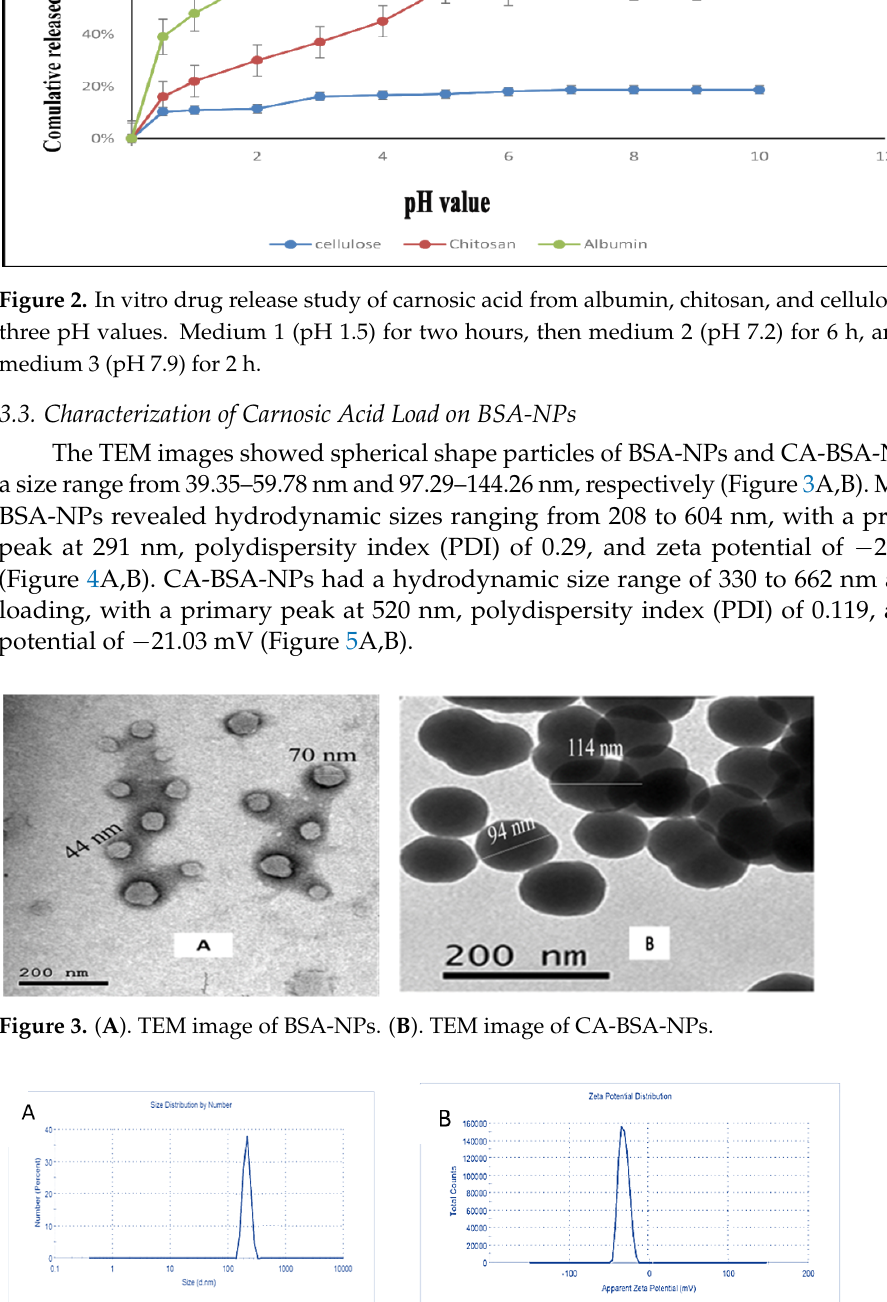
Figure 5. Characterization of CA-BSA-NPs: ( A ). Particle size distribution CA-BSA-NPs; ( B ). CA- BSA-NPs.zeta potential. 3.4. Cell Viability The IC 50 values of free CA against Caco-2 and MCF-7 cells were 8.29 μg/mL and 27.43 mg/mL, respectively. Interestingly, the CA-BSA-NPs significantly reduced the IC 50 values to 2.60 and 6.02 μg/mL for Caco-2 and MCF-7, respectively. Furthermore, after treatment with the same concentration, the MTT assay showed a significant decrease in the cell via- bility after treatment with CA-BSA-NPs, while the BSA-NPs and free CA showed nonsig- nificant cytotoxicity (Figure 6A,B). Figure 6. ( A ) Cell viability of Caco-2 cell line after treatment with carnosic acid, albumin and CA- BSA-NPs.( B ). Cell viability of MCF-7 after treatment with carnosic acid, albumin and CA-BSA-NPs. * means significant difference p < 0.05. 3.5. DNA Content Analysis The flow cytometry was used to evaluate the effect of CA-BSA-NPs on the distribu- tion of cell cycle phases. Results showed that CA-BSA-NPs cell growth arrest was at G 2 /M with 32.75% for Caco-2 cancer cells compared to control, 11.87%, as shown in Figure 7A,B.